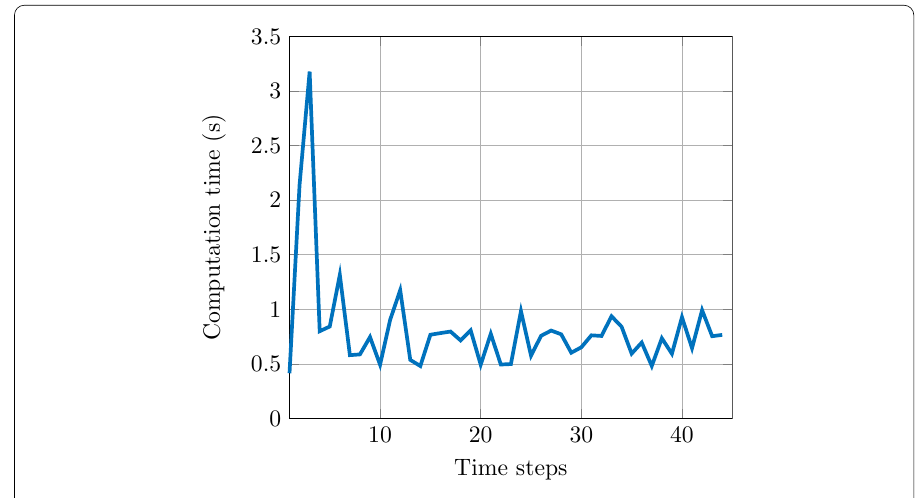
Fig. 17 Computation time including the computation of the transport maps and the command synthesis - Case 1